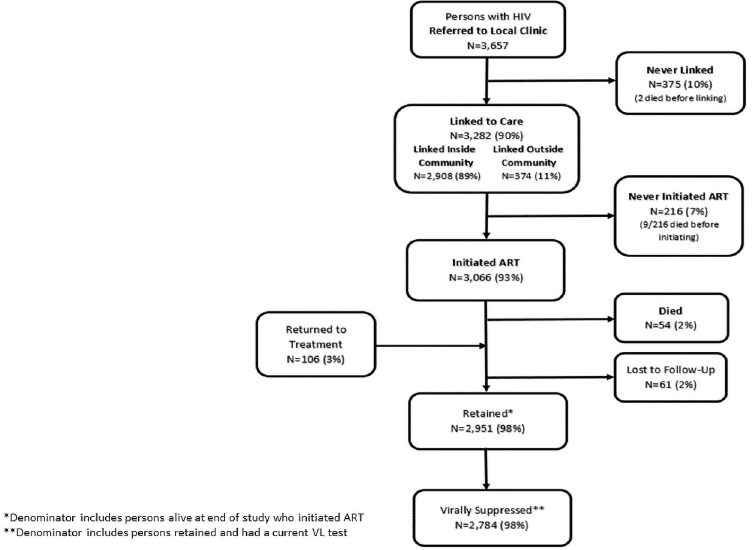
Fig 2. Linkage, ART initiation and retention outcomes among persons referred for care and treatment in intervention communities.